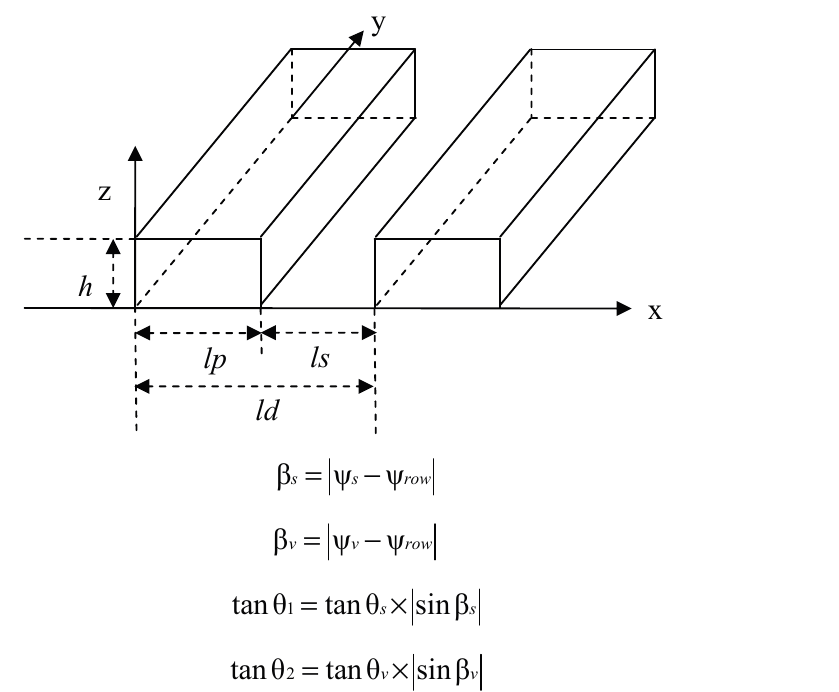
Figure 3. Sketch map of the row crop structure in a cross-row